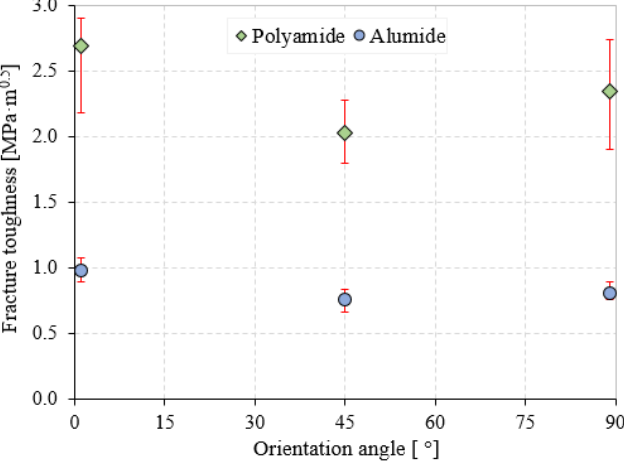
Figure 7. Fracture toughness variation according to the sample orientation angle and material type.